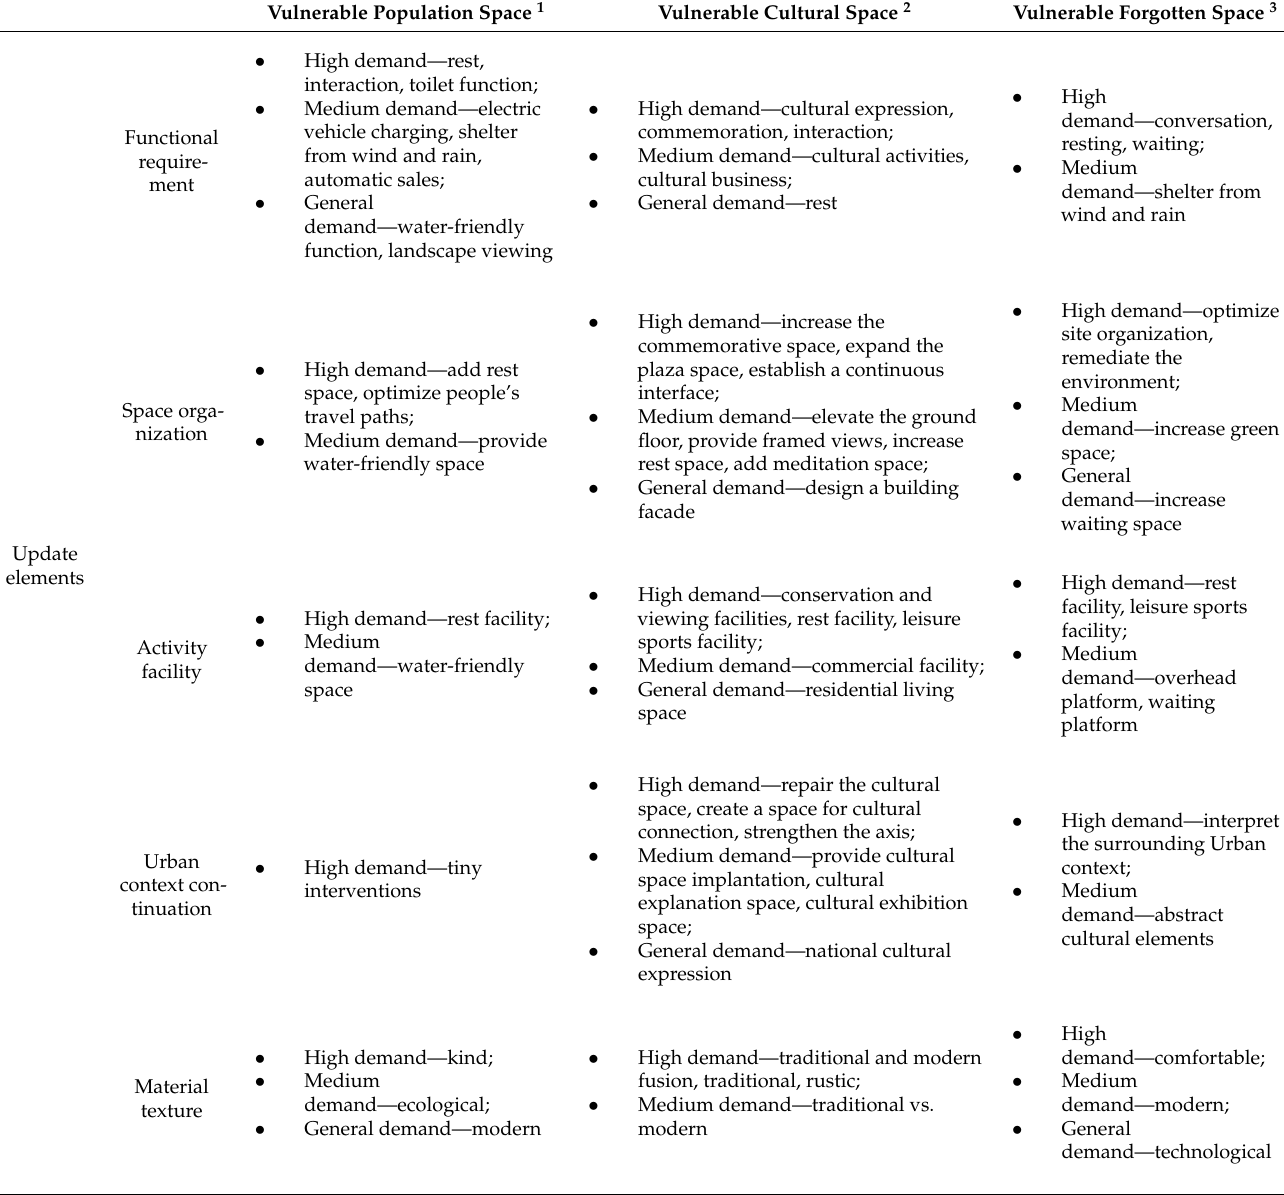
Table 1. Indicators for urban sustainable renewal elements of urban vulnerable